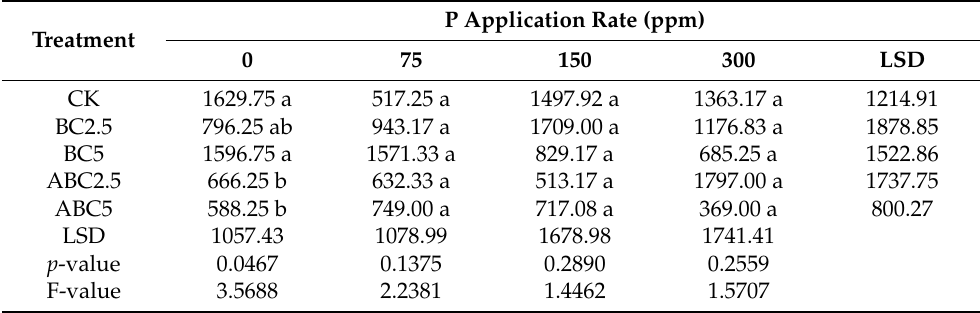
Table 11. Effects of BC and ABC applied at different rates with different P fertilizer application rates on Plant Fe concentration (mg/kg).